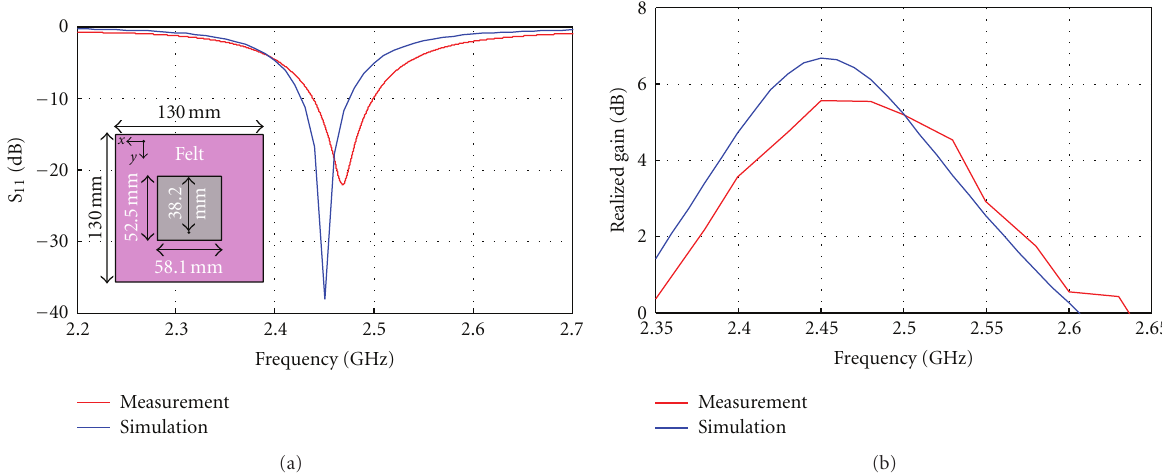
Figure 8: Prototype geometry description and characterization results for patch antenna on felt: return loss (a) and realized gain